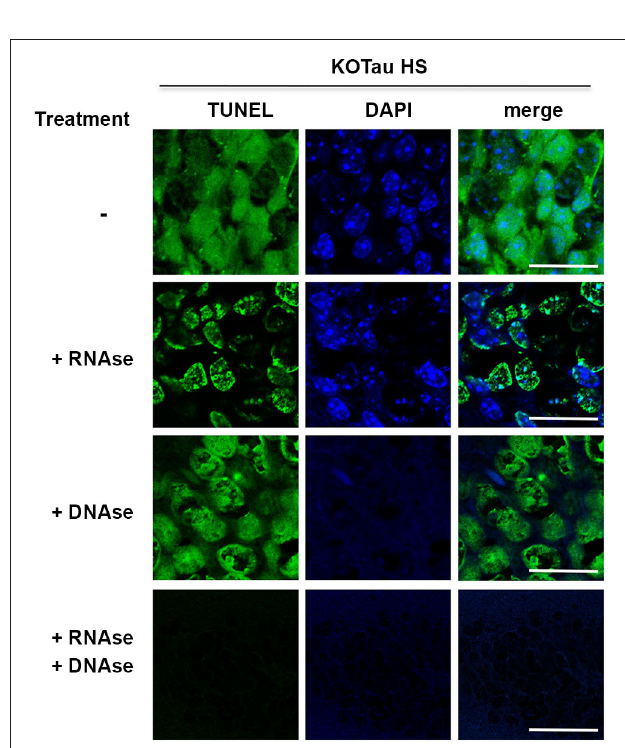
FIGURE 6 | Hyperthermia causes DNA and RNA damage in Tau-deficient neurons. Sagittal hippocampus sections from KO-Tau mice subjected to HS were pre-treated or not with DNAse-free RNAse, RNAse-free DNAse or both before TUNEL staining and imaged using laser scanning confocal microscopy. RNAse pre-treatment fully abolished cytoplasmic staining and reduced nuclear TUNEL staining levels. DNAse pre-treatment fully abolished DAPI staining and reduced nuclear TUNEL staining. These data demonstrated that Tau deficiency induced nuclear DNA and cytoplasmic/nuclear RNA damage under